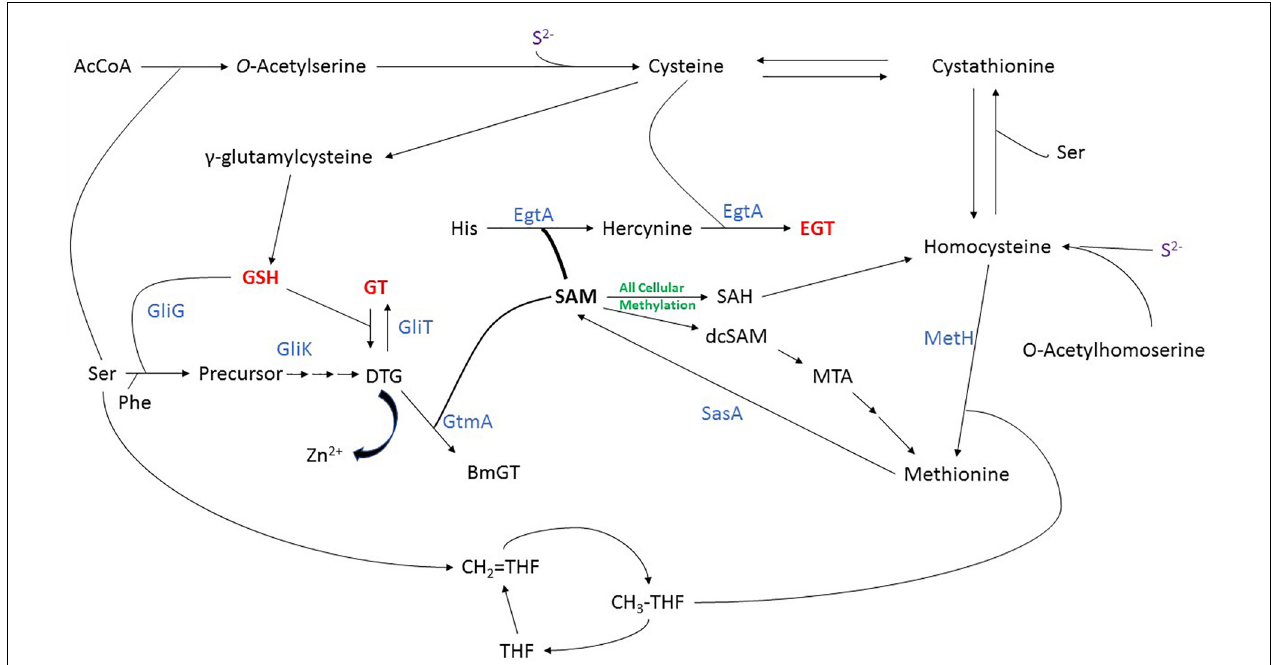
FIGURE 2 | Integrated sulfur metabolism in A. fumigatus , demonstrating the biosynthesis of sulfur-containing amino acids and metabolites, especially gliotoxin, BmGT, dithiol gliotoxin (DTG), ergothioneine (EGT) and GSH. Nascent evidence of interaction between DTG and Zn 2 + is also noted. Enzymes are shown in